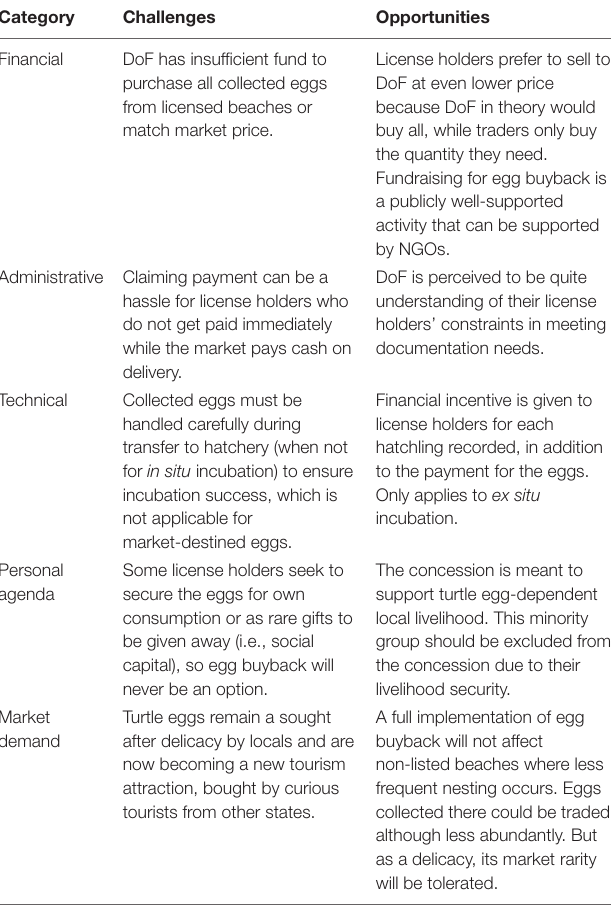
TABLE 3 | Challenges and opportunities in the implementation of the mandatory egg buyback